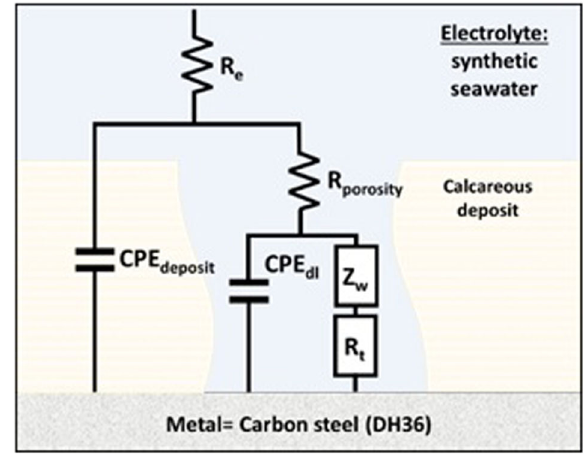
Fig. 9 The EEC model represents the interface of unpainted DH36 steel/seawater under continuous or interrupted cathodic protection. This EEC model is valid at room temperature, under static conditions, and with arti fi cial naturally aerated seawater.